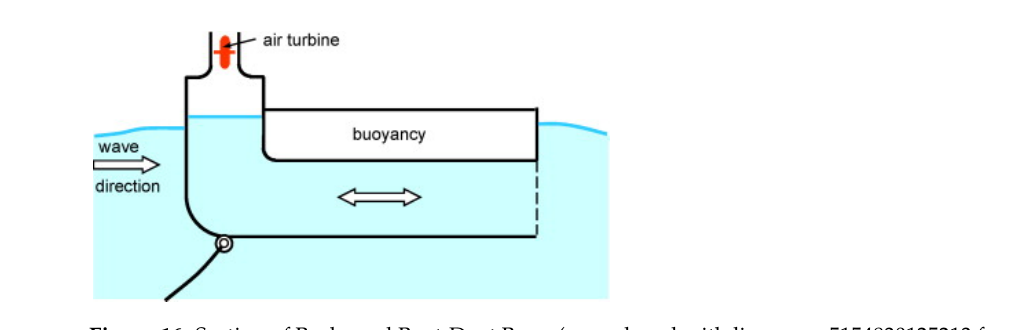
Figure 16. Section of Backward Bent-Duct Buoy (reproduced with license n. 5154830125213 from [32], Elsevier, 2010).